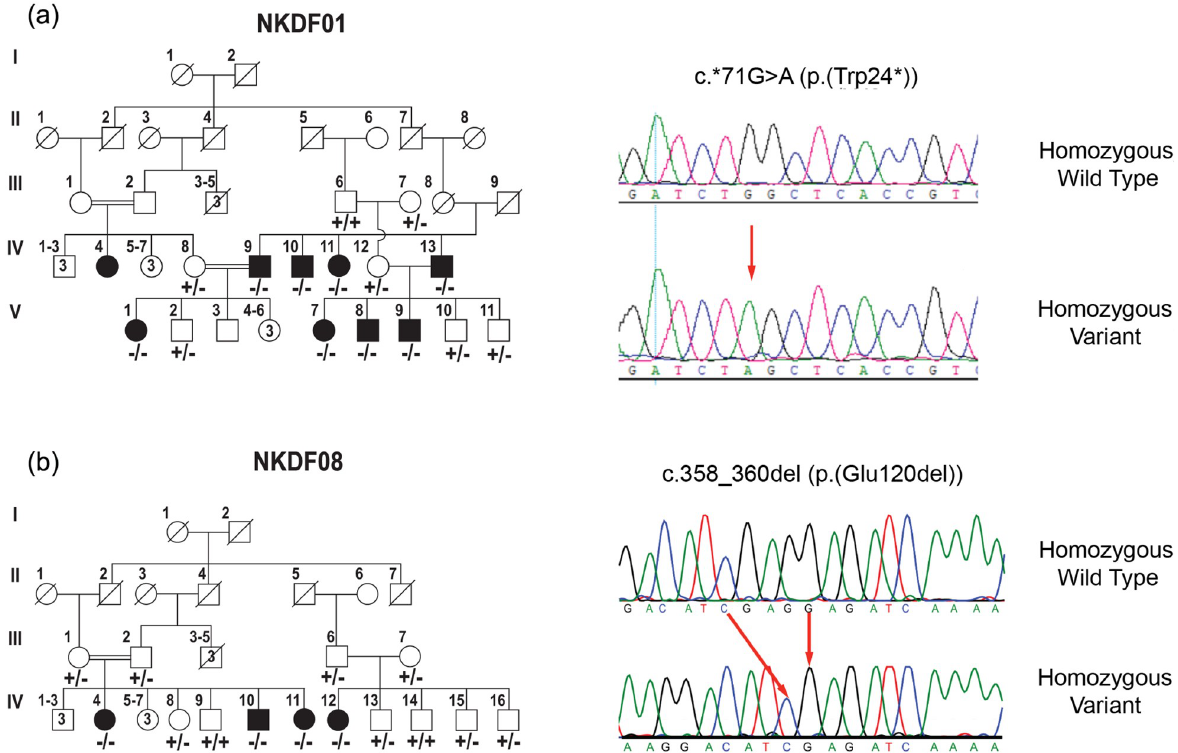
Fig 1. Family pedigrees of hearing impairment and their associated variants. (a) Pedigree of family NKDF01; Black squares and circles represent affected male and female participants, respectively. Consanguineous marriages are denoted by double horizontal lines. Under each symbol, the genotype for the GJB2 variant is given. Sequencing chromatogram of family NKDF01 for individuals V-8 (Affected Son) and III-6 (Normal Father) is provided; the chromatogram shows a homozygous G > A change at 71 position of cDNA (c. � 71G > A) in individual V-8. This change results in a stop codon at 24 amino acid position (p.(Trp24 � )). The position of change is indicated by an arrow in the chromatogram. (b) Pedigree of family NKDF08 and sequencing chromatograms for individuals IV-9 (Normal Son) and IV-10 (Affected son). Chromatogram shows a homozygous c.358_360del change which results in p.(Glu120del) variant in individual IV-10. The position of change is indicated by arrows in the chromatogram.